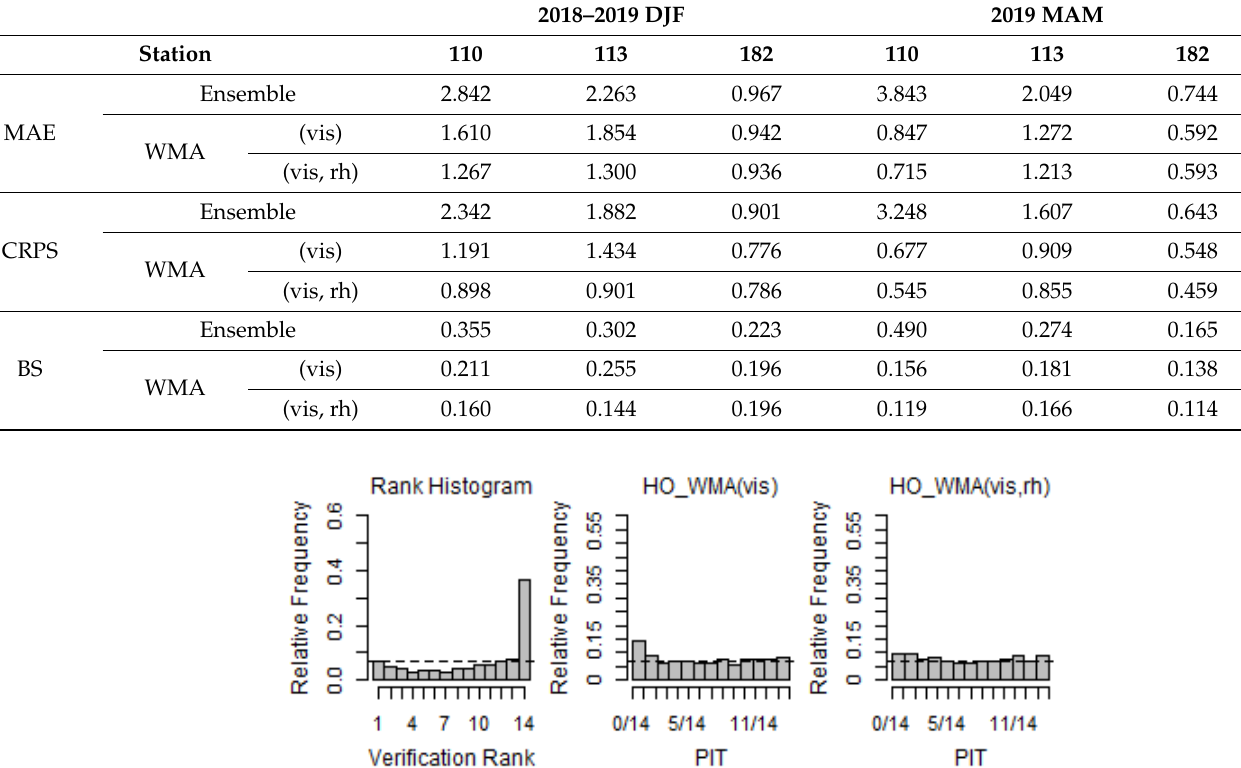
Table 7. Comparison of model performance in terms of MAE, CRPS, and BS.